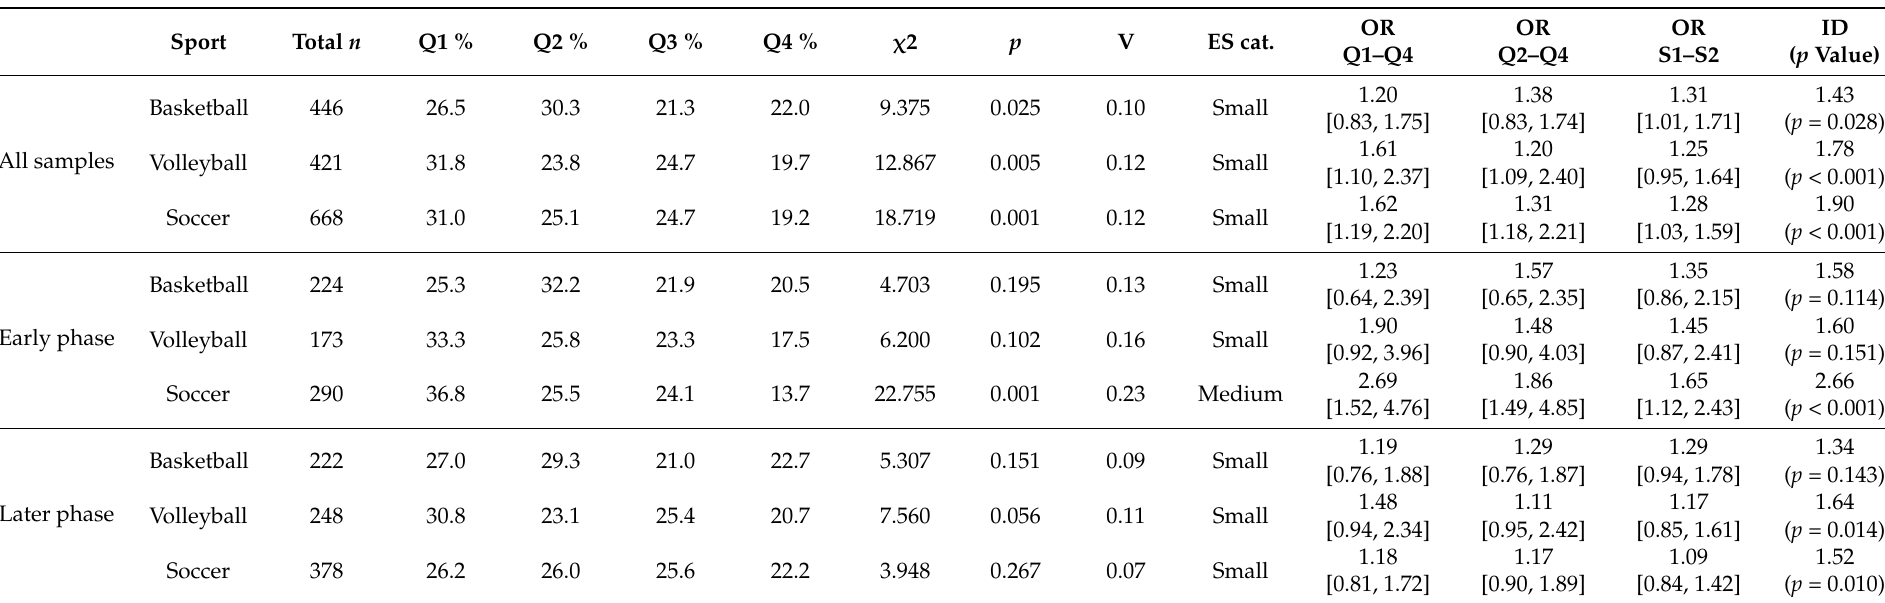
Table 1. Relative age distribution, chi-square value, and odds ratio analysis of basketball, soccer, and volleyball